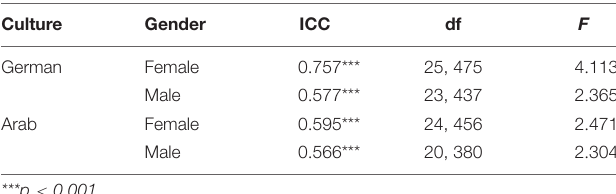
the dyads with high, medium, and low average rapport